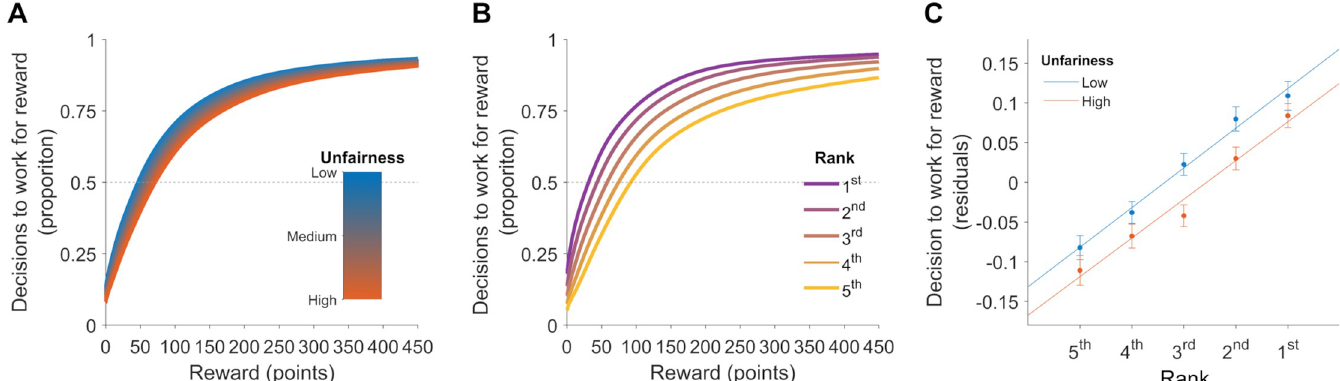
Fig 4. Motivation to work is higher when the distribution of rewards is fair; the rank is high, and the absolute reward is high. To illustrate the effect of factors influencing the motivation to work in repeated measures experiments, we plotted the probability of participants’ decision to work from a GLME model predicting choice from reward magnitude and either different levels of (A) unfairness or (B) rank. (C) We also plotted average residuals for the five rank categories and two levels of unfairness from a GLME model predicting choice just from absolute reward and trial number. We observe that participants are more likely to decide to work when (A, C) rewards are fairly distributed and (B, C) when the rank is high than low. Error bars =